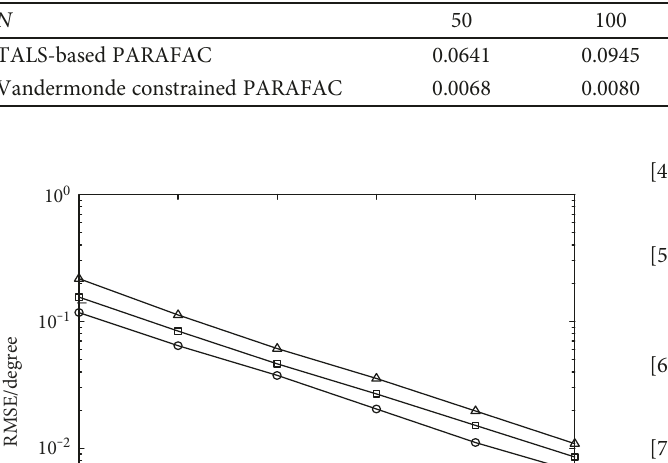
Table 2: Average run time (s) of respective algorithms.